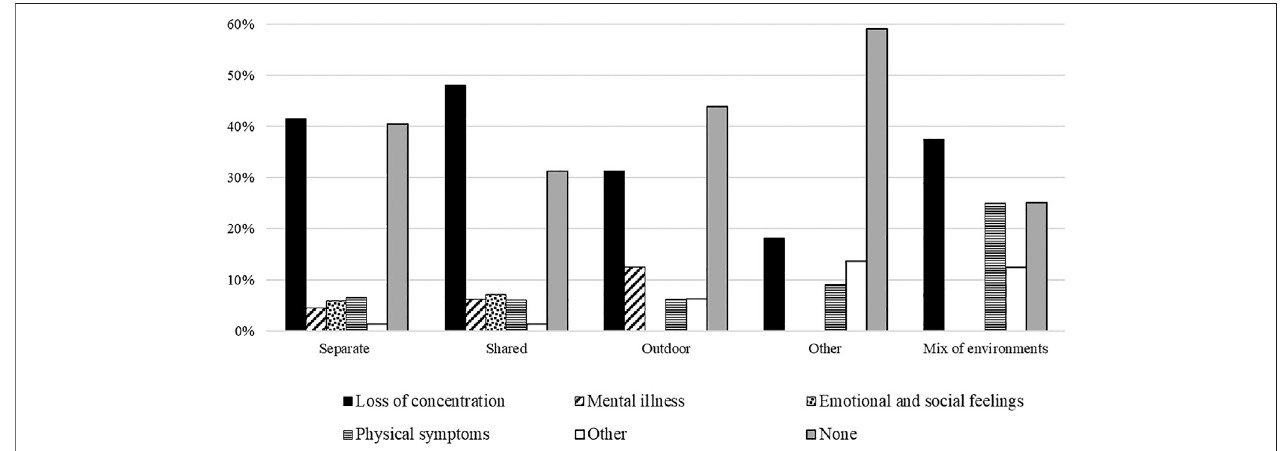
FIGURE 3 | Percentages ofthe subjective ratings of the effects of noise in the different remote working environments on mental health and well-being (i.e., feelings and symptoms).